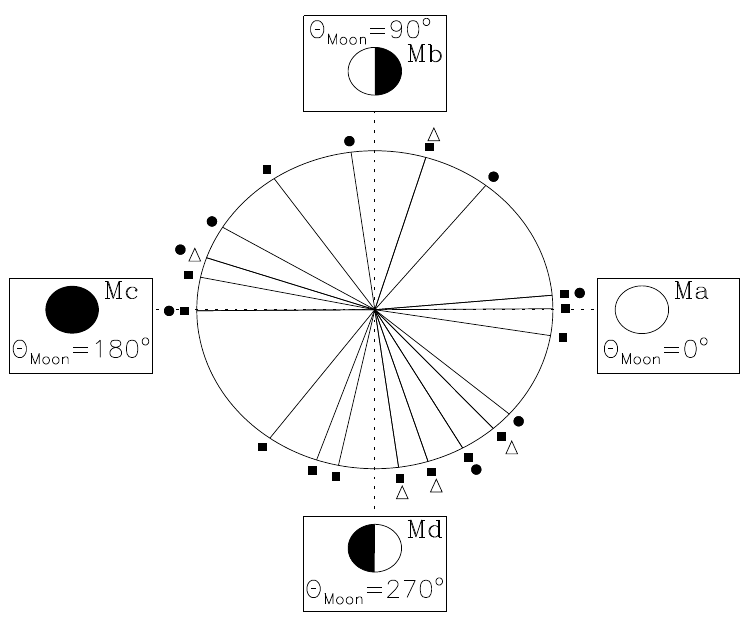
Figure 3. Θ Moon of the lucky time points of Table 3. Time runs in the counter-clockwise direction on this circle. Epochs Ma, Mb, Mc and Md are separated by 90 degrees and they are denoted with dotted straight lines. The phases of the Moon are shown in the small boxes. The Full and the New Moon occur at Ma and Mc, respectively. The phase angle values Θ Moon of “Horus” (closed squares) “Seth” (open triangles) and “Osiris” (closed circles) are denoted with continuous straight lines.